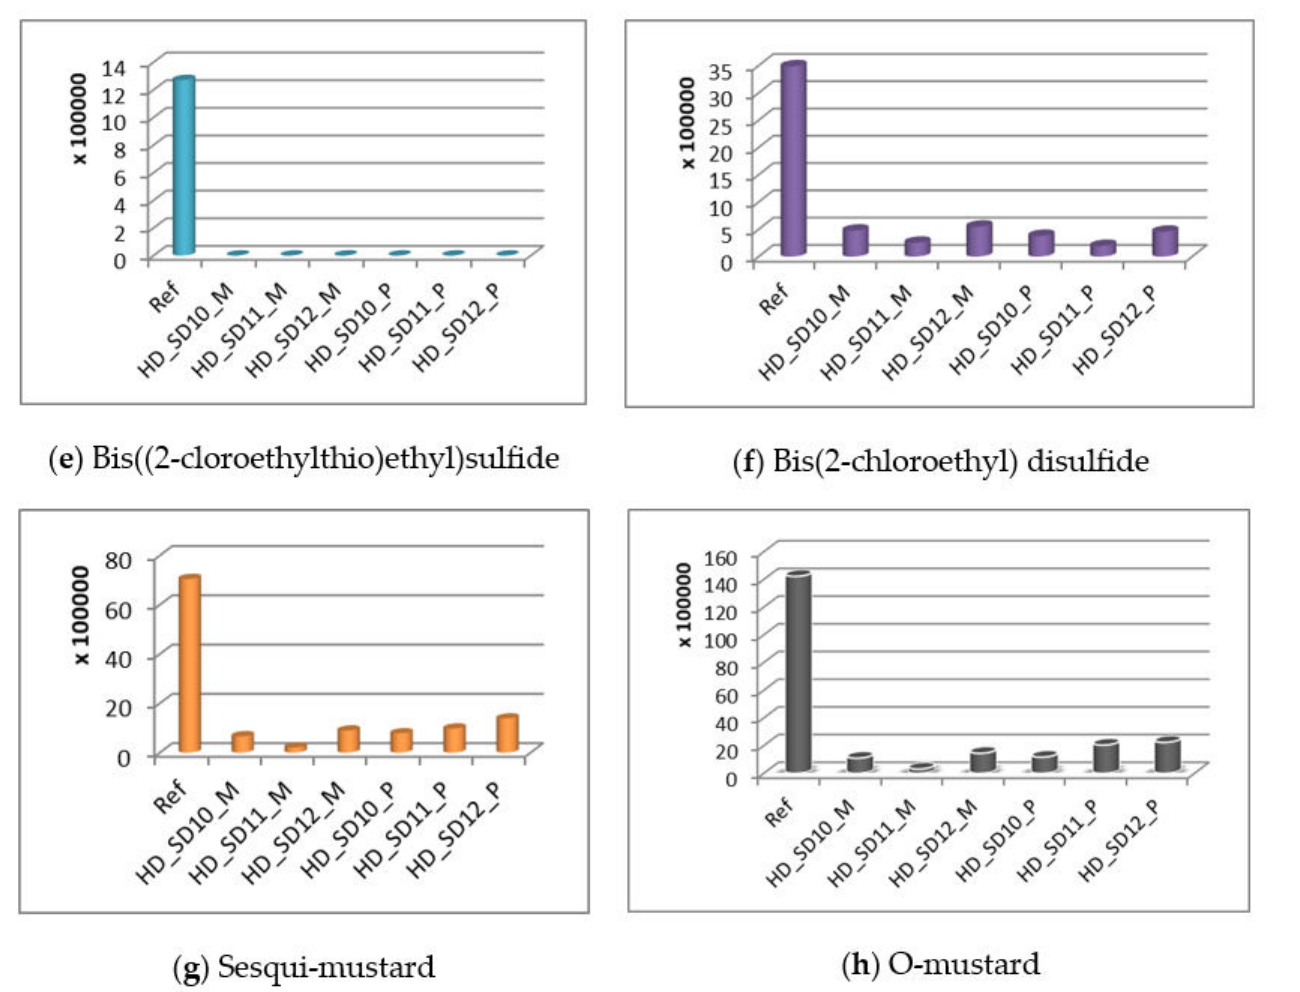
Figure 11. Degradation products of HD tracked during the decontamination process ( y -axis values correspond to the values obtained for the area of the specific peak (counts) of each analyte): ( a ) sulfur mustard, ( b ) 1,4—dithiane, ( c ) thiodiglycol, ( d ) ethanol.2-((2-chloroethyl)thio)1-acetate, ( e ) Bis((2-cloroethylthio)ethyl)sulfide, ( f ) Bis(2-chloroethyl) disulfide, ( g ) sesqui- mustard and ( h )